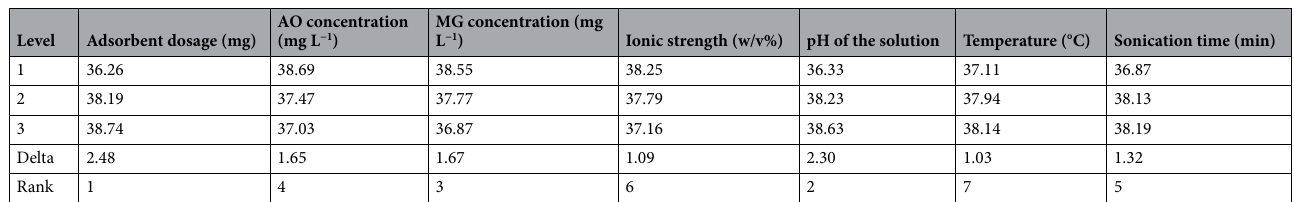
Table 4. Response table for signal to noise ratios for MG and